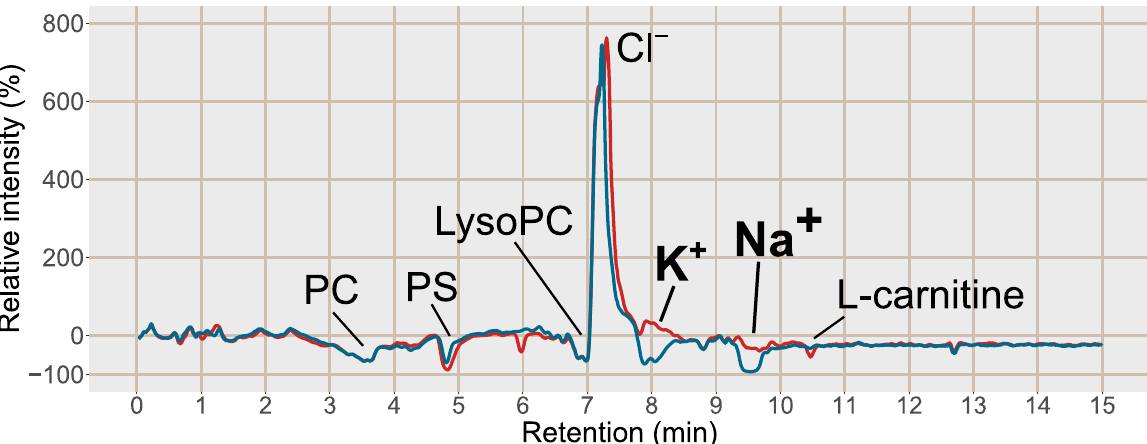
Figure 3. Post-column infusion chromatogram of guanine (2* 13 C, 15 N) with the relative intensity in % as compared to the injection of a solvent blank on the y-axis 100*(Intensity MCX or PPT /Intensity blank ) − 100. Blue line = injection of blood plasma treated with PPT, red line = injection of blood plasma treated with SPE MCX. Each line is based on the average of 3 samples of each type, PPT, SPE MCX or a solvent blank. Major suppressions/enhancements are annotated in the chromatogram, PC = phosphatidylcholines, PS = phosphatidylserines, LysoPC = Lysophosphatidylcholines, K + = potassium formate cluster K + (HCOOK), m / z 122.926, Na + = sodium formate cluster Na + (HCOONa) 3 ), m / z 226.954, Cl − = potassium chloride cluster, K + (KCl), m / z 112.8963. Metabolites 2021 , 11 , 170